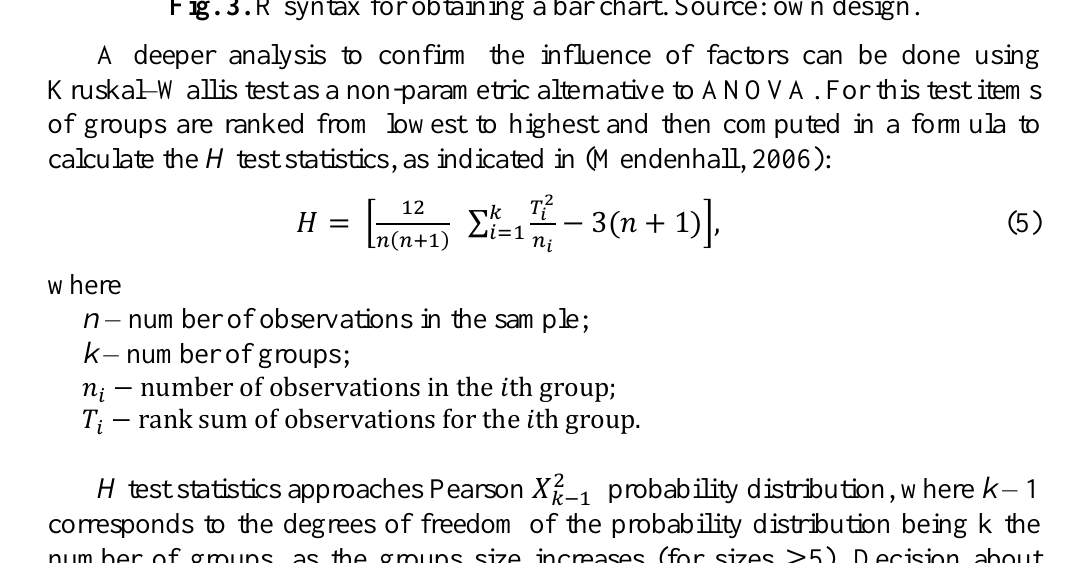
Fig. 3. R syntax for obtaining a bar chart. Source: own